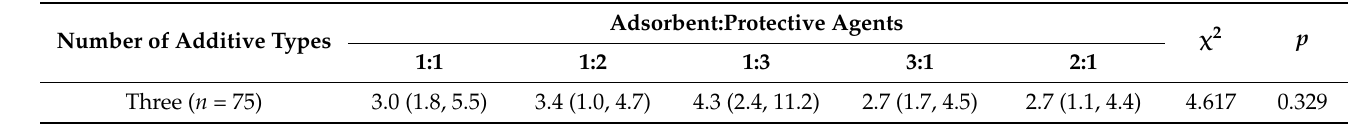
Table 4. Nonparametric test of the viable bacterial count at different ratios between adsorbent and protective agents (CFU/g;